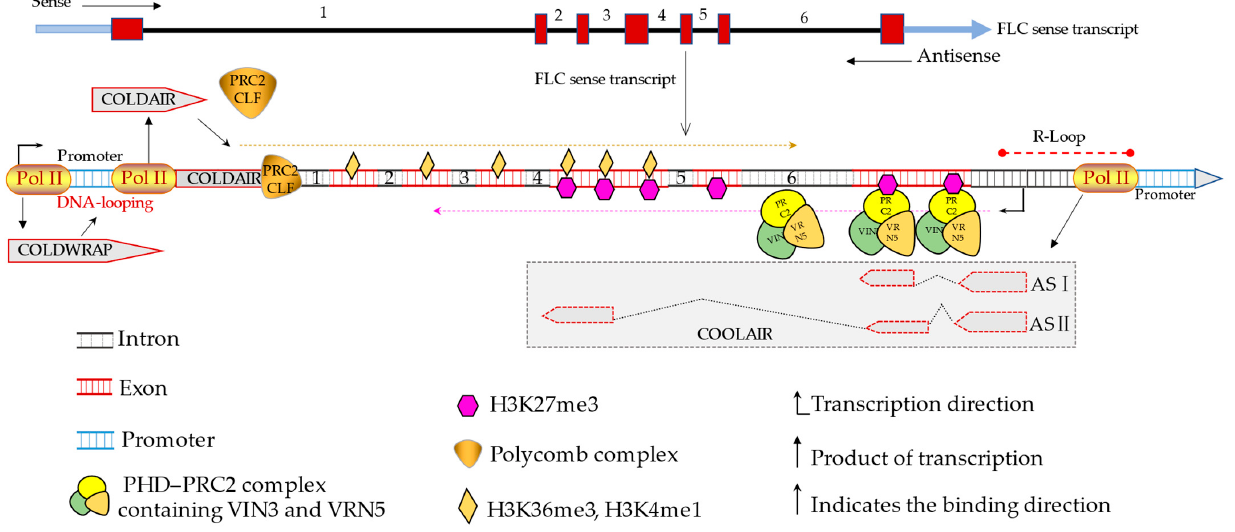
Figure 3. COOLAIR , COLDWARP , and COLDAIR are involved in regulating vernalization response of FLC gene [19]. COLDAIR is transcribed from the first intron of FLC . It inhibits the establishment of H3K27me3 and induces H3K4me3 by recruiting and directing PRC2-CLF to FLC [78]. COLDWRAP is from the promoter of FLC induced by vernalization. COLDWRAP and COLDAIR collaborate to establish a restrictive intracellular chromatin loop [79]. COLDWRAP binds to PRC2-CLF, localizes to FLC gene, and promotes vernalization of FLC chromatin in response to H3K27me3 [79]. COOLAIR has two alternatively spliced isoforms (AS I and AS II). R-loop stabilization mediated by AtNDX inhibits COOLAIR transcription, thereby altering FLC expression [83]. The nucleation region consists of VIN3, VRN5, and PRC2, and accumulates as part of the PHD–PRC2 complex downstream of the FLC transcription start site [81]. The aggregation of the nucleation region leads to a decrease in H3K4me3/H3K36me3 and an increase in H3K27me3 [82]. AS: alternative splicing; PRC2: polycomb repressive complex 2; green boxes indicate exons of COOLAIR , AS I and II represent exons, dotted lines indicate splice sites; the red dotted line represents the R-loop; the yellow and purple dotted lines indicate the modification direction; numbers represent introns; H3K4me1, histone H3 lysine 4 monomethylation; H3K36me3, histone H3 lysine 36 trimethylation; H3K27me3, trimethylation of histone H3 lysine